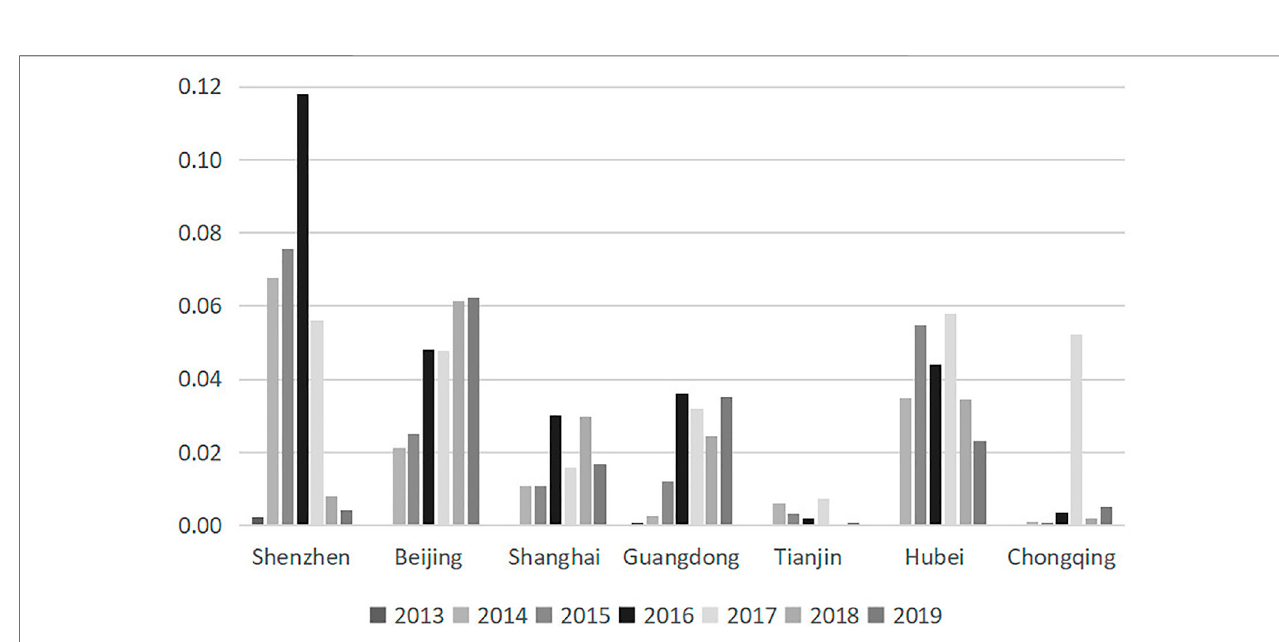
FIGURE 3 | Carbon emissions trading quota-turnover ratios of the seven pilots 2013 – 2019. Source: china carbon emissions trading network.